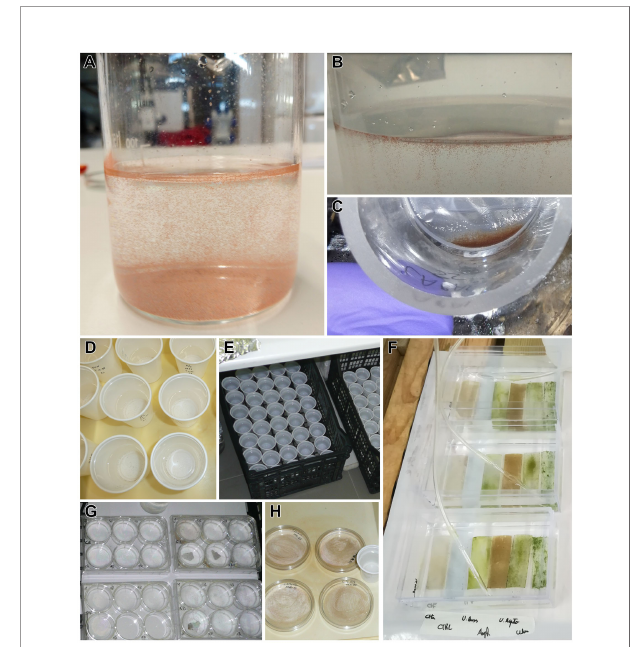
FIGURE 2 | Different containers used for the culture of limpets. Glass beaker (600 ml), used for alkaline treatment, fertilization, incubation, and larval culture (A, B) : glass beaker showing a pool of trochophores (A) , and trochophores swarming near the water surface (B) . Mesh (55 µm) used to gather the